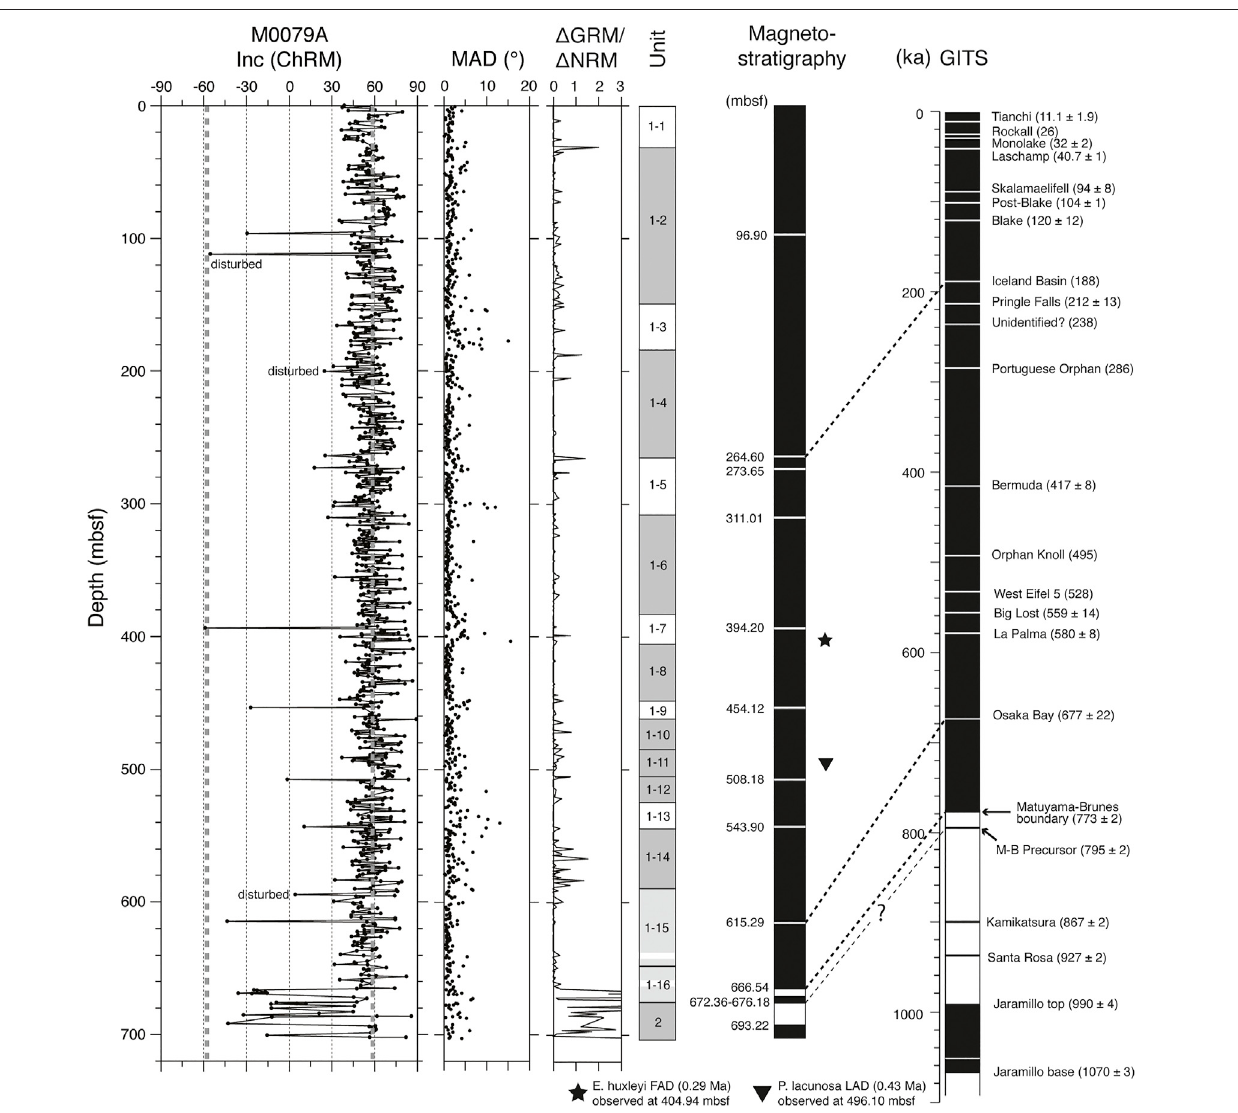
FIGURE4| Fromlefttoright:ChRMinclinations;maximumangulardeviation(MAD)values(Kirschvink,1980); Δ GRM/ Δ NRMvaluesasgreigiteconcentrationproxy (Fu et al., 2008); unit and subunit distribution according to McNeill et al. 2019b; magnetostratigraphy of Hole M0079A; and the geomagnetic instability time scale (GITS; Singer, 2014). Excursions in the GITS are from Channell et al. (2020), with ages in ka in brackets. Gray thick dotted lines in the ChRM inclination plot are the expected inclinations for both normal and reverse polarity at the samplinglocality (i.e.,57.5 ° ).Grey shaded areas in theunit logare theisolated/semi-isolatedglacialintervals. Light grey intervals (SU 1 – 15 and 1 – 16) are unde fi ned (likely isolated) intervals. FAD = fi rst appearance datum. LAD = last appearance datum. Correlations (thin dotted lines) between the magnetostratigraphy of Hole M0079A and the GITS are shown.